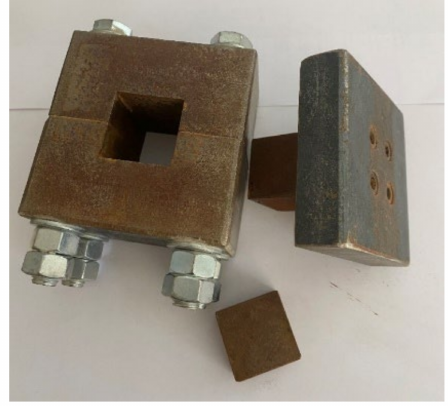
Figure 2. Mold used in the laboratory for the specimen shaping.